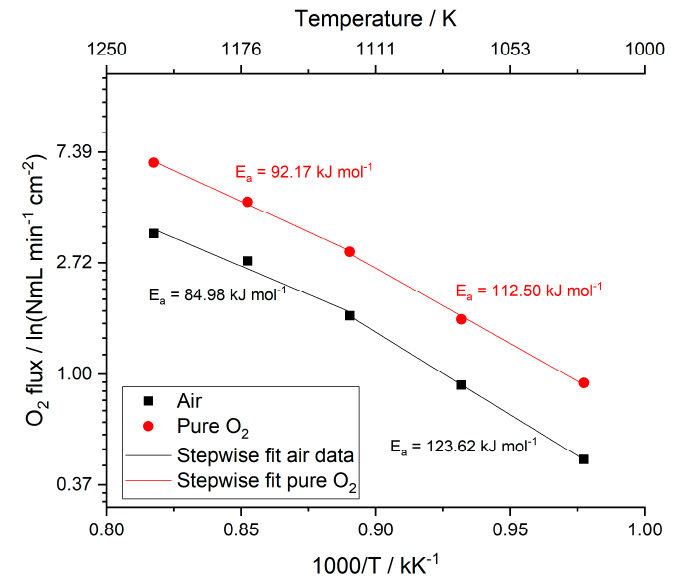
Figure 8. Oxygen flux as a function of the inverse of the temperature. Permeation tests performed by feeding air or pure oxygen as process gas and helium as sweep gas, with a flow rate of 100 NmL min − 1 between 750 °C and 950 °C.